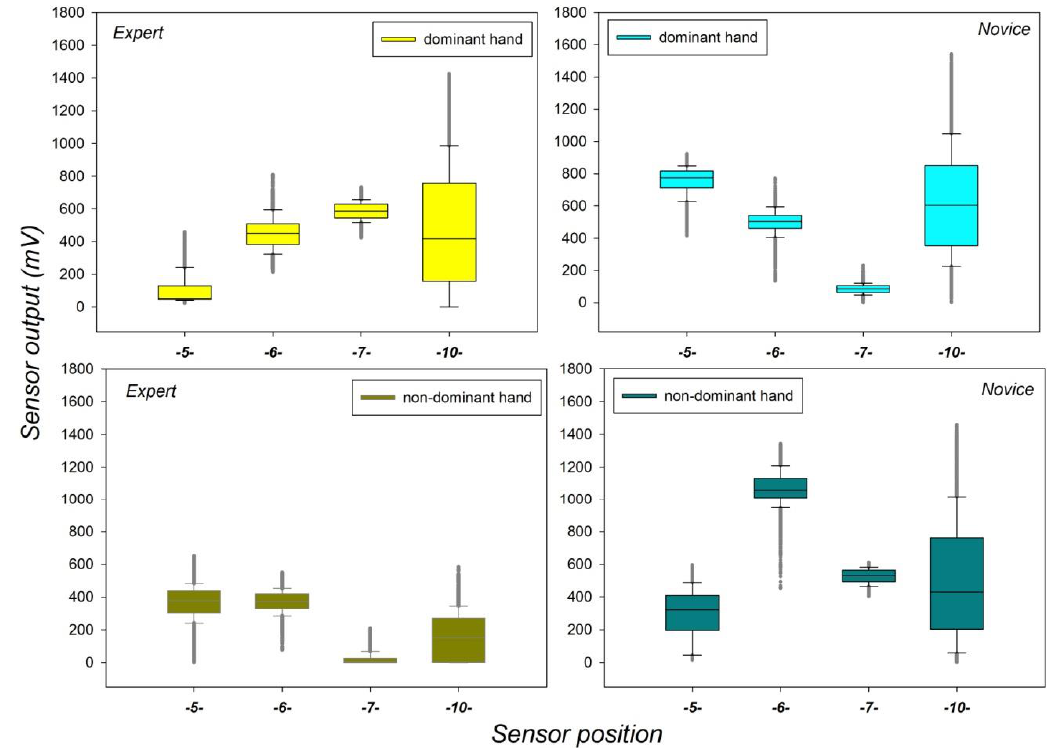
Figure 6. Dynamic range of grip force data recorded for the expert and the novice from each task- relevant sensor position in successive sessions with the dominant and non-dominant hands.